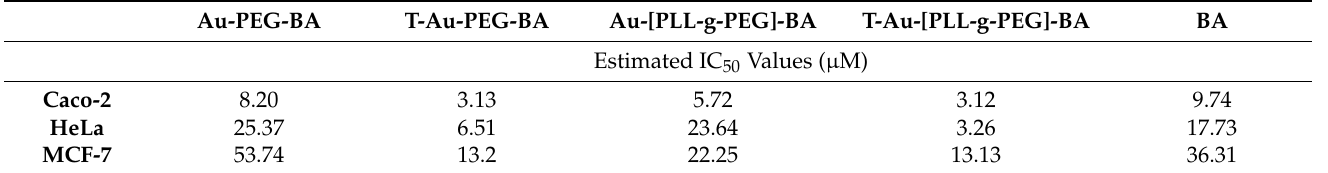
Table 2. Estimated IC 50 values of BA, targeted and untargeted nanocomplexes.